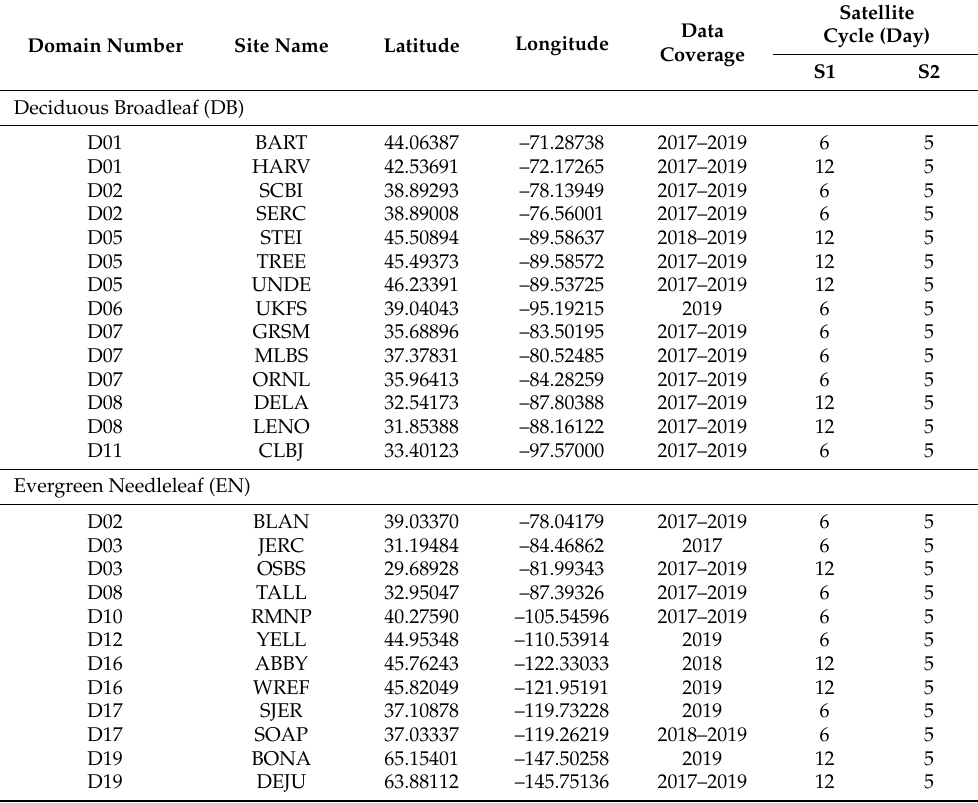
Table 1. Information of selected field sites (14 deciduous broadleaf sites and 12 evergreen needleleaf sites) and the corresponding data